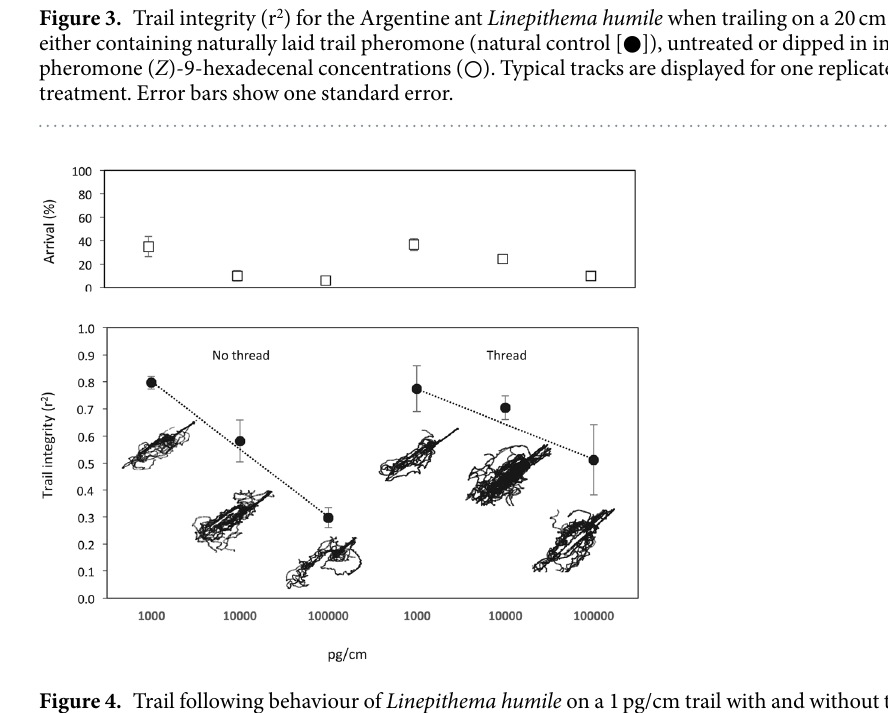
Figure 4. Trail following behaviour of Linepithema humile on a 1 pg/cm trail with and without thread present, located 1 cm downwind from three high rate trails of ( Z )-9-hexadecenal on glass, no thread data re-analysed from 41 . Typical tracks are displayed for one replicate from each treatment. Error bars show one standard